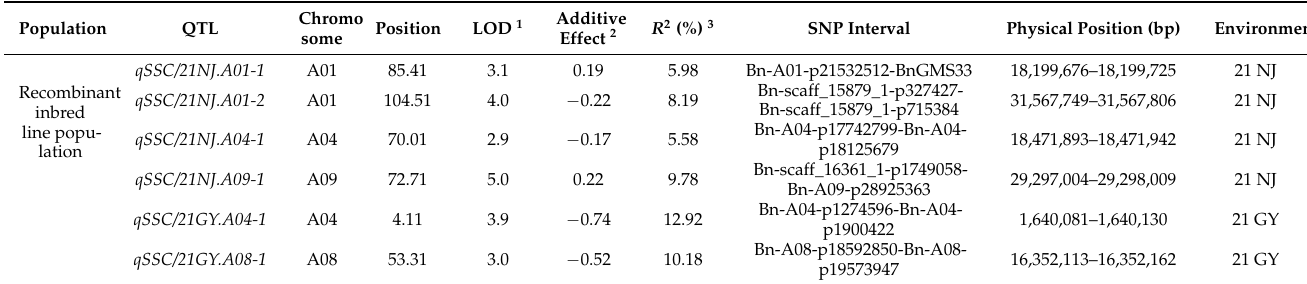
Table 2. Quantitative trait loci for soluble solids content of the recombinant inbred line population under different environmental conditions.